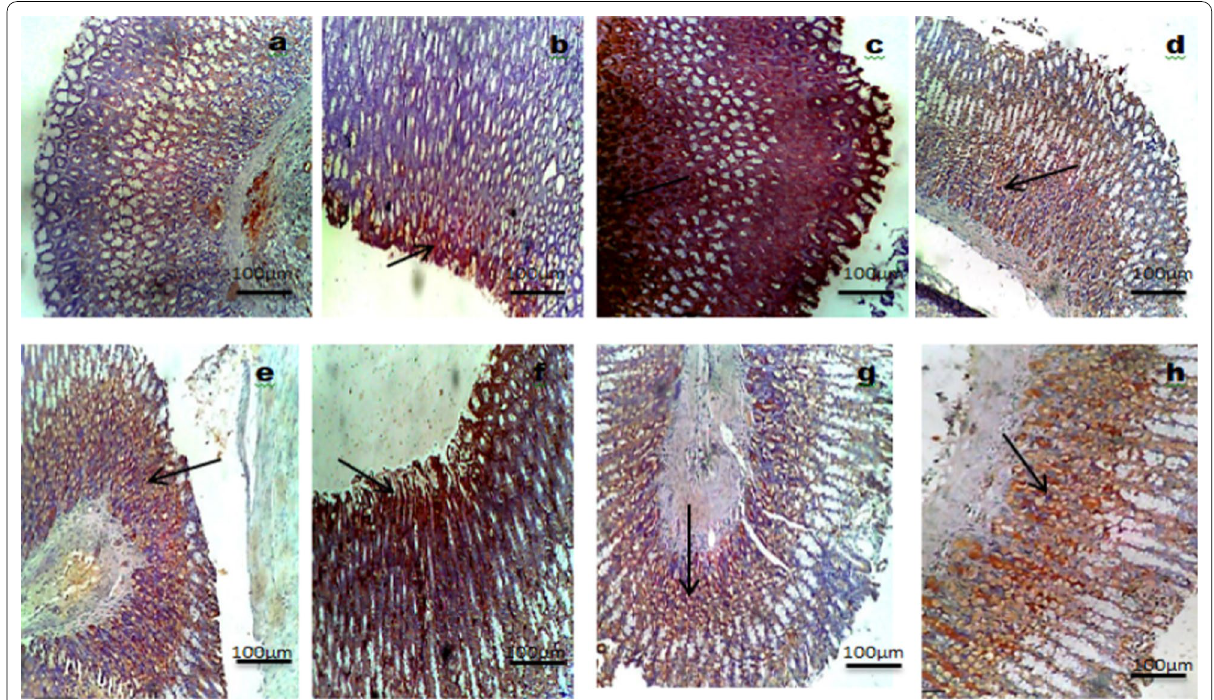
Fig. 12 IHC slides for evaluation of EGFR positive immunoreactive cells during healing of acetic acid stomach ulcer pretreated with folic acid and omeprazole. (H&E, X100). a Acetic acid stomach ulcer untreated (Day 5). b Acetic acid stomach ulcer treated with 2 mg/kg Folic acid (Day 5). c Acetic acid stomach ulcer treated with 3 mg/kg Folic acid (Day 5). d Acetic acid stomach ulcer treated with Omeprazole (Day 5). e Acetic acid stomach ulcer untreated (Day 10). f Acetic acid stomach ulcer treated with 2 mg/kg Folic acid (Day 10). g Acetic acid stomach ulcer treated with 3 mg/kg Folic acid (Day 10). h Acetic acid stomach ulcer treated with Omeprazole (Day 10). Black arrow: Point of